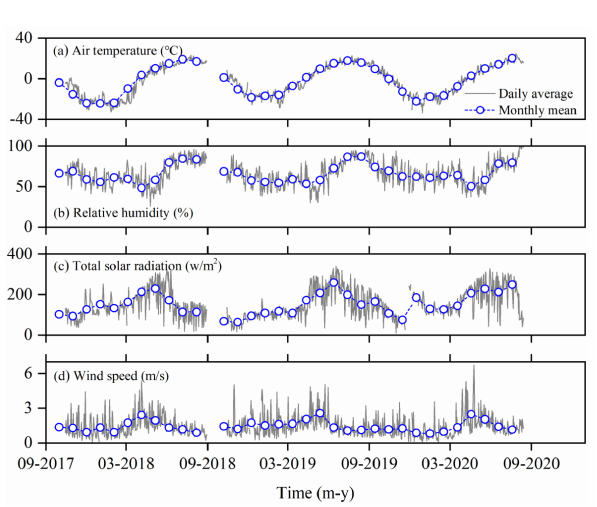
Figure 2. Time series of meteorological variables at the JB site from October 2017 to August